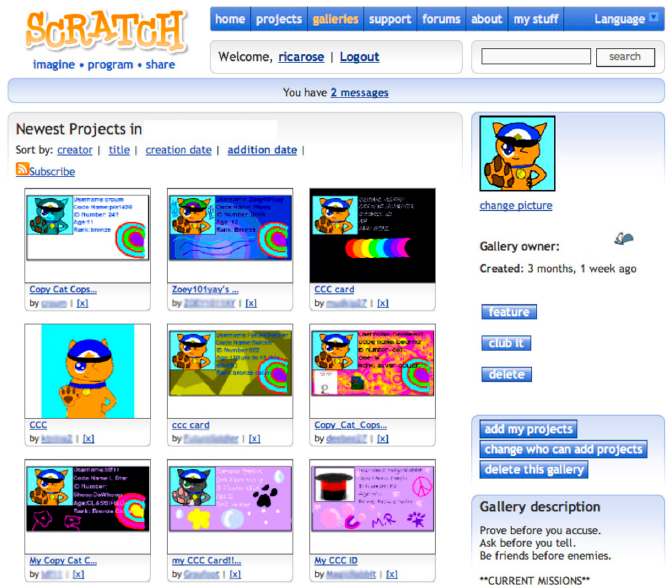
Figure 10. Gallery of one of the vigilante groups.